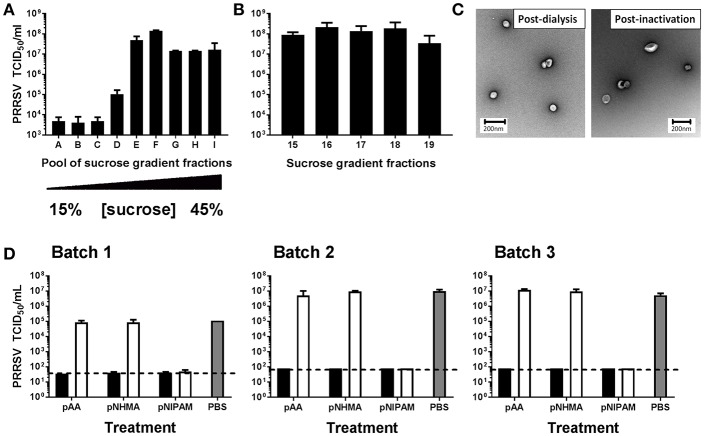
Assessment of PRRSV-1 neutralization by virus-imprinted hydrogel MIPs. Template virus was prepared by purification of PRRSV-1 virions by continuous density ultracentrifugation. Pools of gradient fractions (A) and individual fractions (B) containing the highest infectious titers were selected and virion purity and integrity post-dialysis and inactivation confirmed by electron microscopy (C). Three independently produced batches of MIPs were tested for their ability to neutralize PRRSV-1 infectivity in vitro
(D). A suspension of PRRSV-1 was incubated for 1 h with pAA, pNHMA or pNIPAM MIPs (closed bars). Non-imprinted polymers (NIPs; open bars) and PBS (gray bars) were included as negative controls. Post-incubation, MIP/NIPs were removed by centrifugation and the infectious viral titers in supernatants determined by immunoperoxidase staining of inoculated cell monolayers. The mean infectious PRRSV titers, expressed as 50% tissue culture infectious doses (TCID50), for technical triplicates of each treatment condition are presented and error bars represent the standard error of the means. The limit-of-detection of the assays are indicated by dashed horizontal lines.